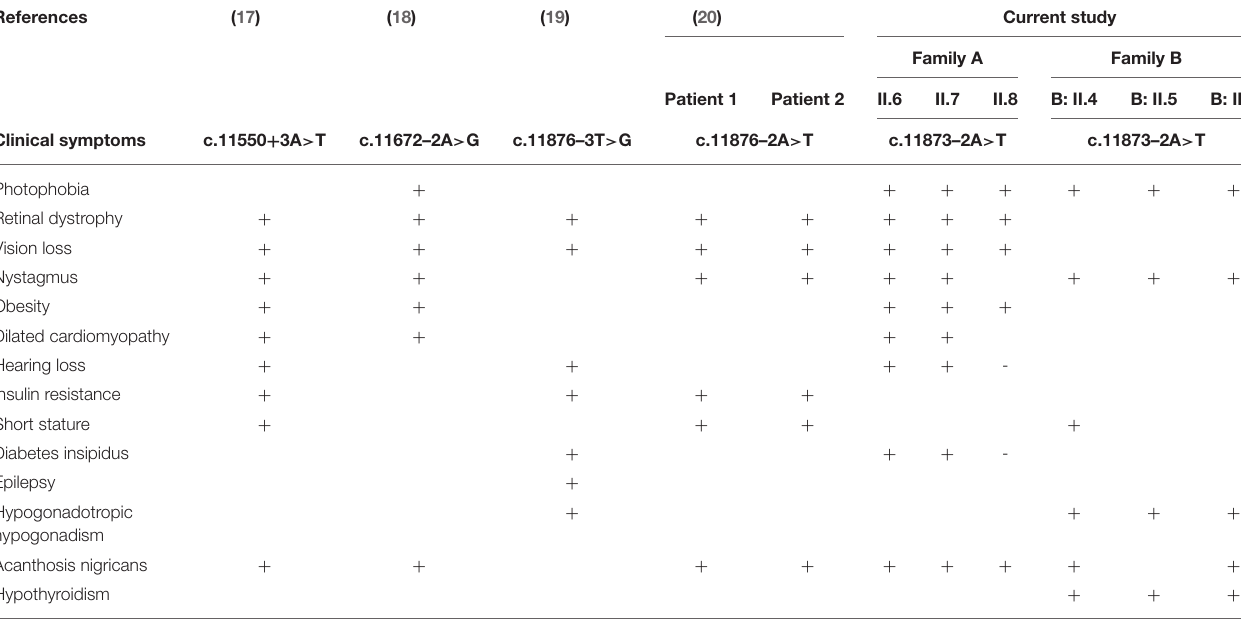
had a history of long standing cough with yellow sputum that is precipitated by moderate